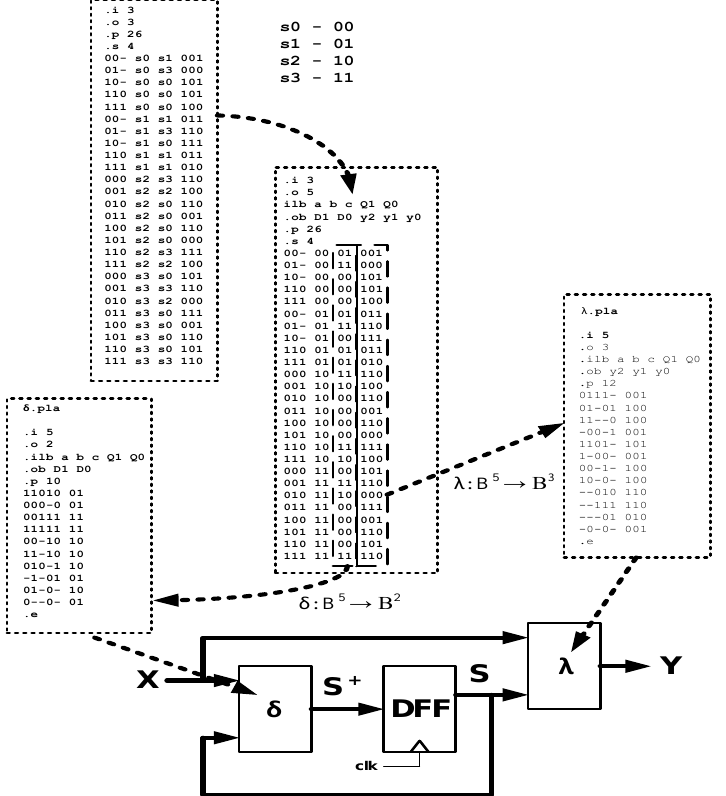
Figure 6. The result of separate implementation of transition and output blocks of